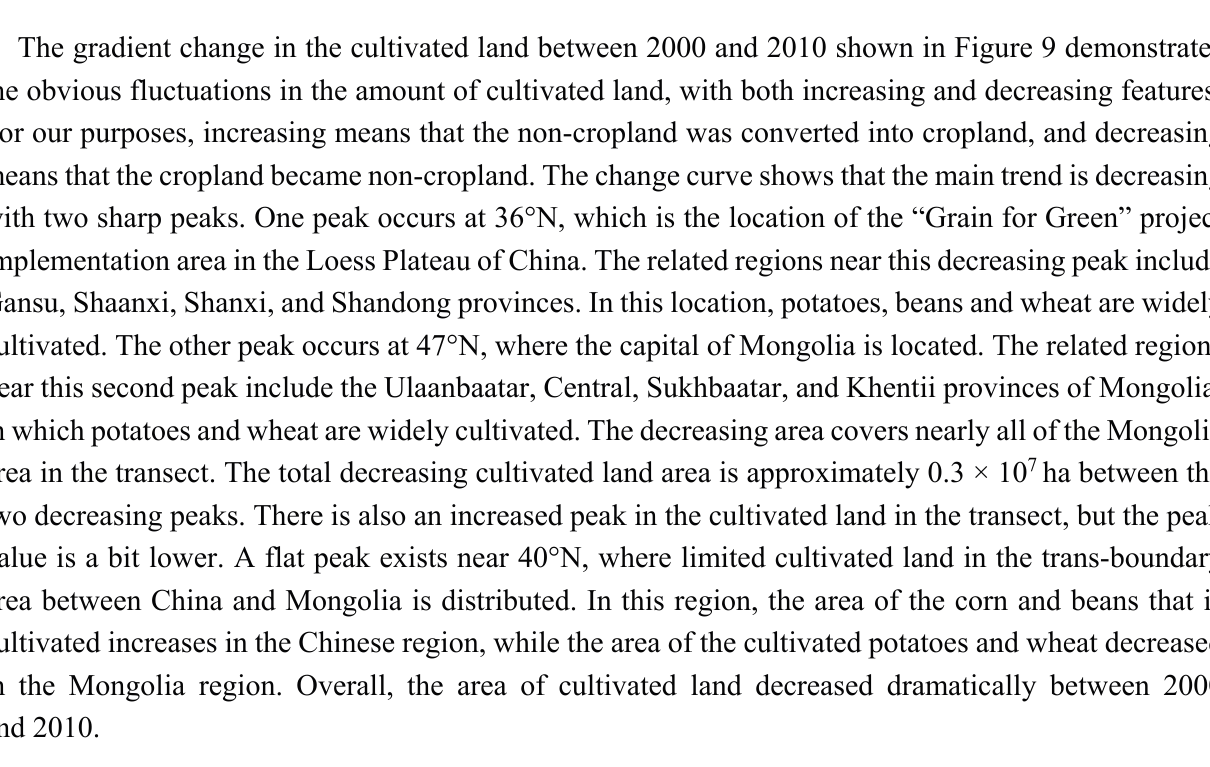
Figure 9. The latitudinal gradient distribution of cultivated land in 2000 and